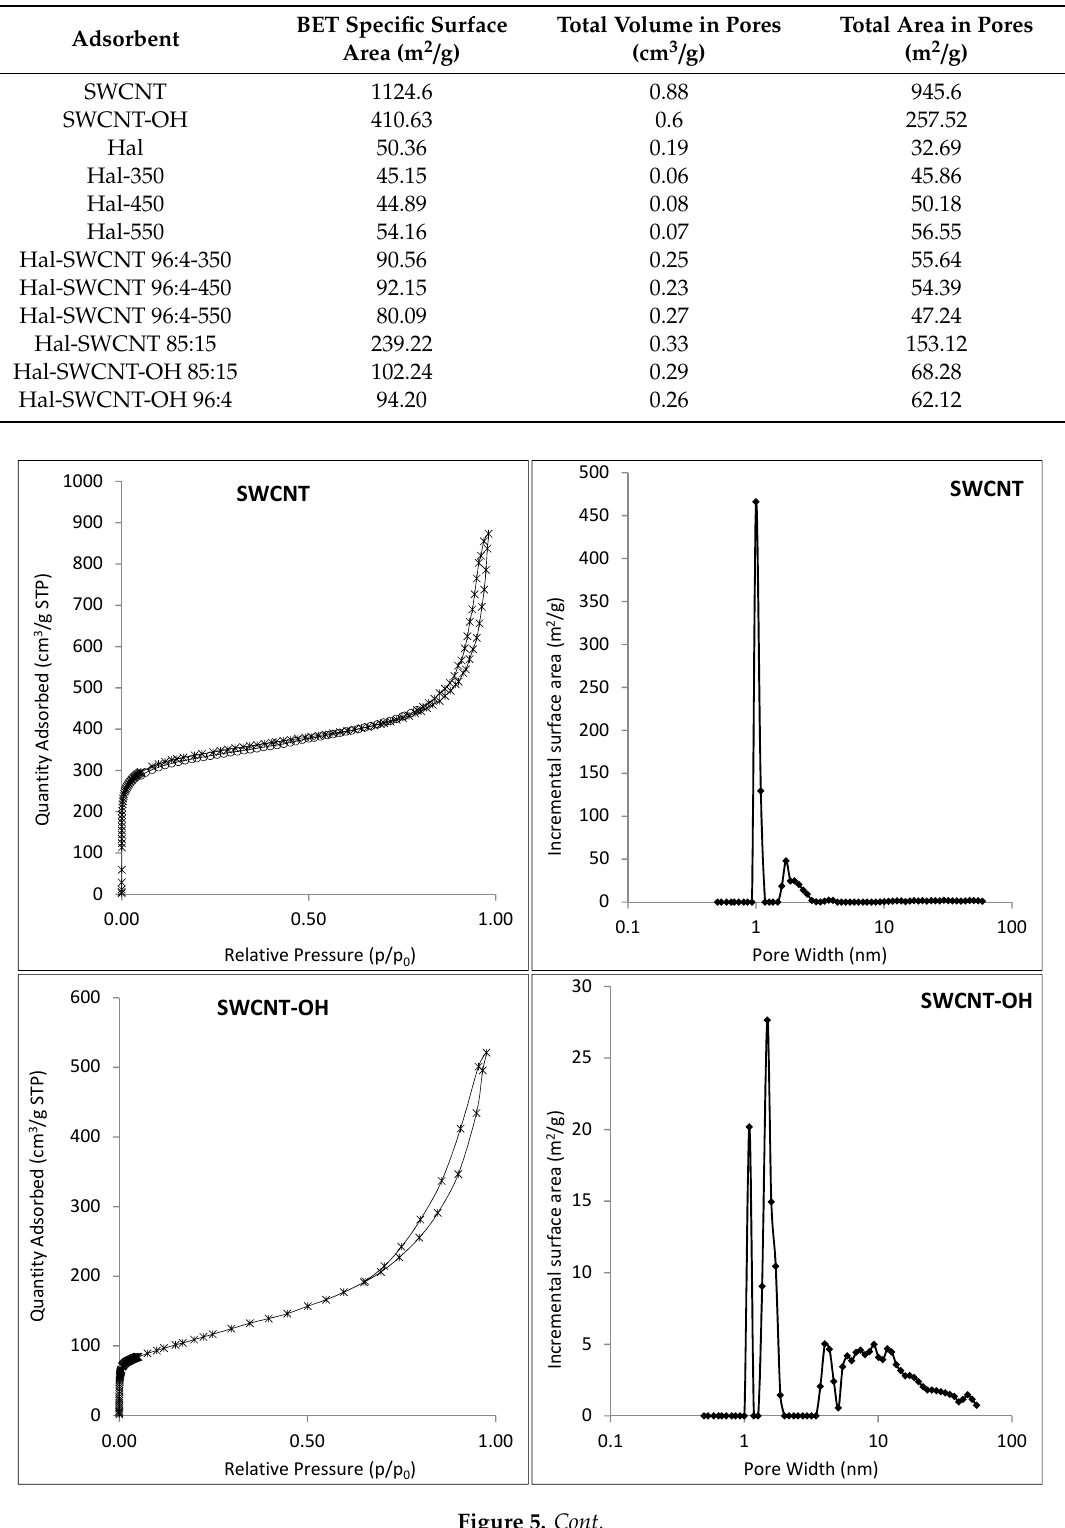
Table 4. The characteristic of SWCNT, SWCNT-OH, Hal, Hal-350, Hal-450, Hal-550 and Hal-CNT composites from nitrogen sorption-desorption measurements.